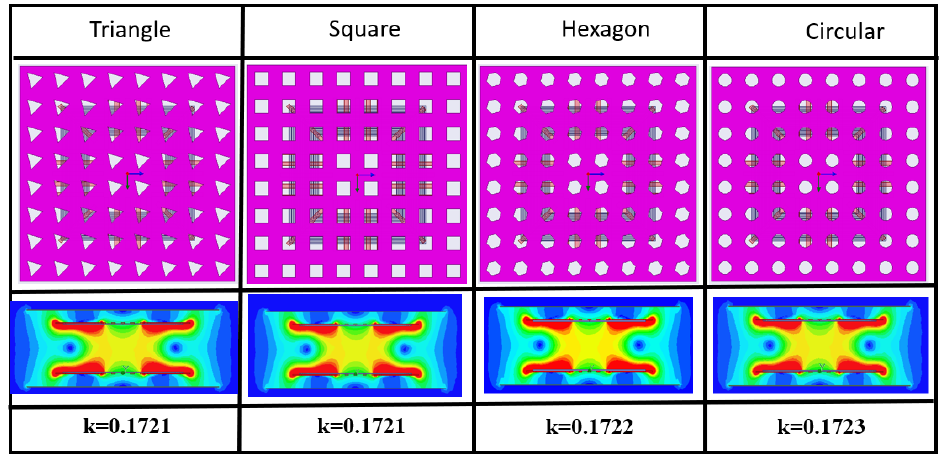
Figure 5. Comparison of electromagnetic field distribution of wireless transmission systems with different mesh aluminium plates.